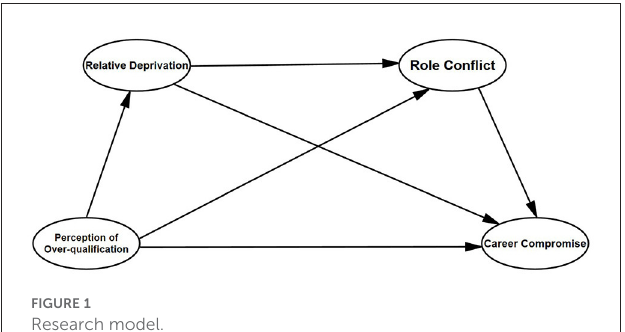
FIGURE1 Research